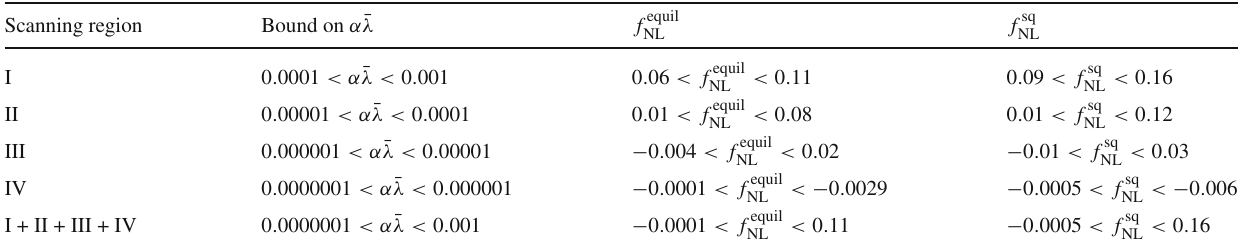
Fig. 11 Representative S , T and U channel Feynman–Witten diagram for bulk interpretation of three point scalar correlation function in the presence of graviton exchange contribution. In all the diagrams the graviton is propagating on the bulk and the end points of the scalars Table 4 Constraint on scalar three point non-Gaussian amplitude from equilateral and squeezed configuration Scanning region Bound on α ¯ λ f equil